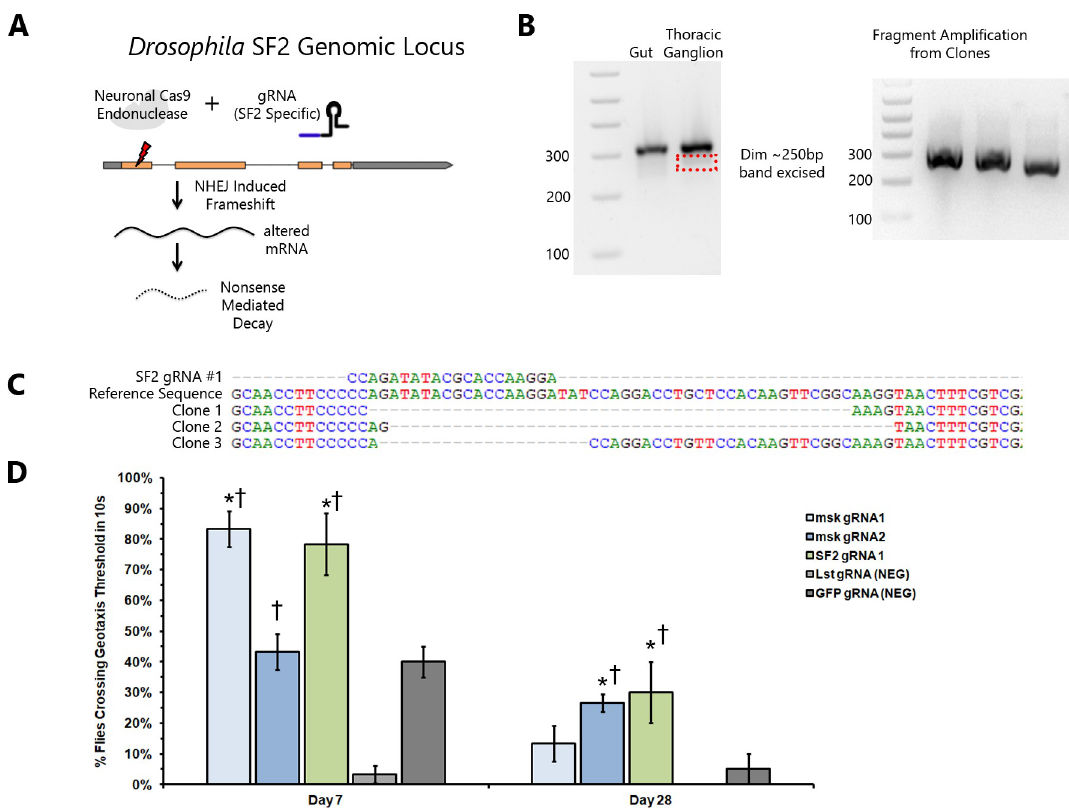
Fig 2. Motor neuron specific CRISPR/CAS9 knock-out of msk/importin-7 and of SF2/SRSF1 are each sufficient to prevent TDP- 43 mediated defects in negative geotaxis. (a) Overview of CRISPR/Cas9 knock out strategy. gRNAs specific to SF2/SRSF1 or msk/ importin-7 (see S3 Table ) are expressed constitutively in all cells by a U6 promoter plasmid integrated into the AttP2 landing site. Cas9 expression is restricted to E49 neurons, limiting editing to those cells. (b) Gel electrophoresis of PCR products from dissected tissues of male F1 offspring. Gel 1 Lanes: DNA ladder, Gut amplification product (no editing), thoracic ganglion amplification product (editing in some neurons). A faint band corresponding to reduced size predicted from edited products was excised and cloned into a sequencing vector. Gel 2 Lanes: DNA Ladder, and three independent PCR amplifications from sub-cloned edited inserts. These show variable size corresponding to stochastic NHEJ editing of target gene. (c) DNA sequence of edited fragments. Sequences from top to bottom: guide RNA targeting SF2 gene, reference SF2 sequence, clones 1–3 showing variable deletions caused by NHEJ repair. (d) Negative geotaxis of F1 E49 > TDP-43 , Cas9; U6-gRNA males over an aging time-course. Y axis shows % flies (average of three trials) crossing a 10cm threshold after 10 second (negative geotaxis testing). X axis indicates time point (7 days or 28 days post eclosion). Bar color indicates gene targeted by gRNA. � P < 0.001 by Student’s T test in comparisons to GFP control. † P < 0.001 by Student’s T test in comparisons to lst